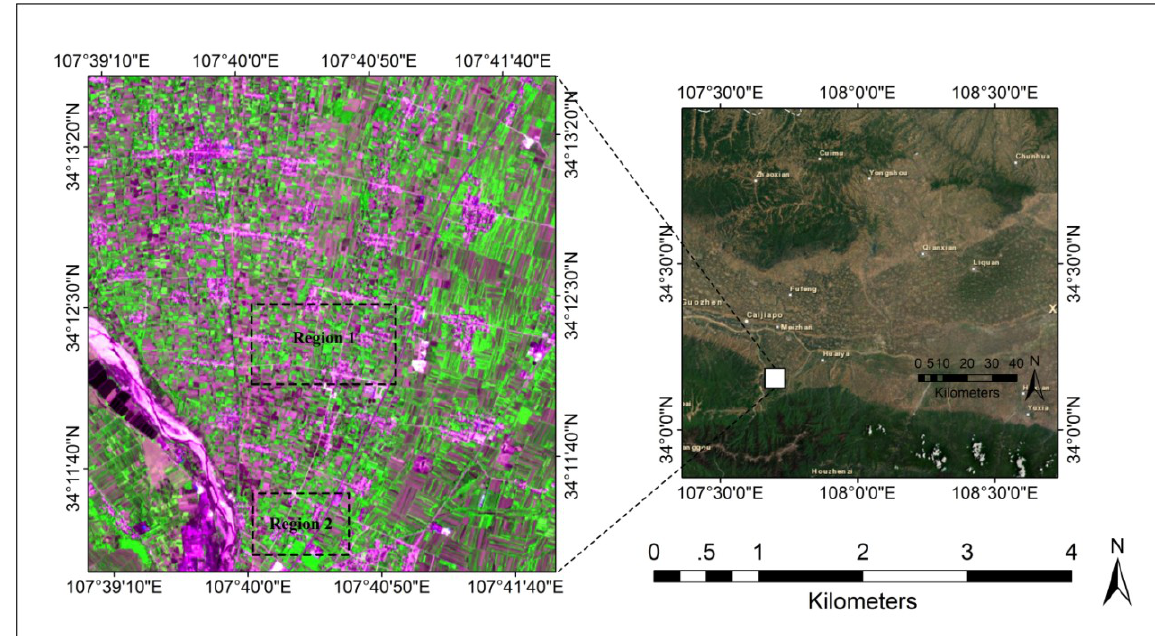
Figure 1. Locations of the two study regions.